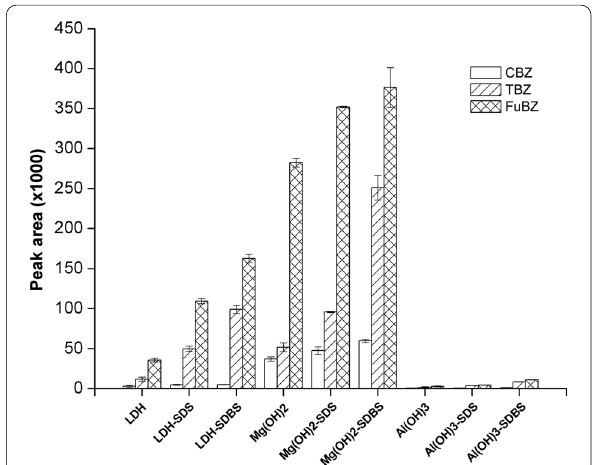
Fig. 2 Effect of NaOH volume on the extraction recovery of target fungicides (100 µg/L each). Conditions: 300 mmol/L MgCl 2 (90 μL), 0.5 mol/L NaOH, and 10 mmol/L SDBS (350